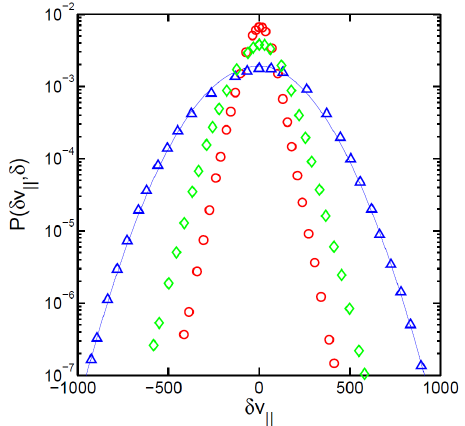
Fig. 8. P(δv || ,δ) at large scale from ROMA scaling relations: red (circles) for δ = 24 1 ; green (diamonds) for δ = 96 1 ; blue (trian- gles) for δ = 640 1 . The solid blue curve shows a Gaussian distribu- tion of the following form with an asymmetric factor with σ = 210 and a s = 0 . 2: